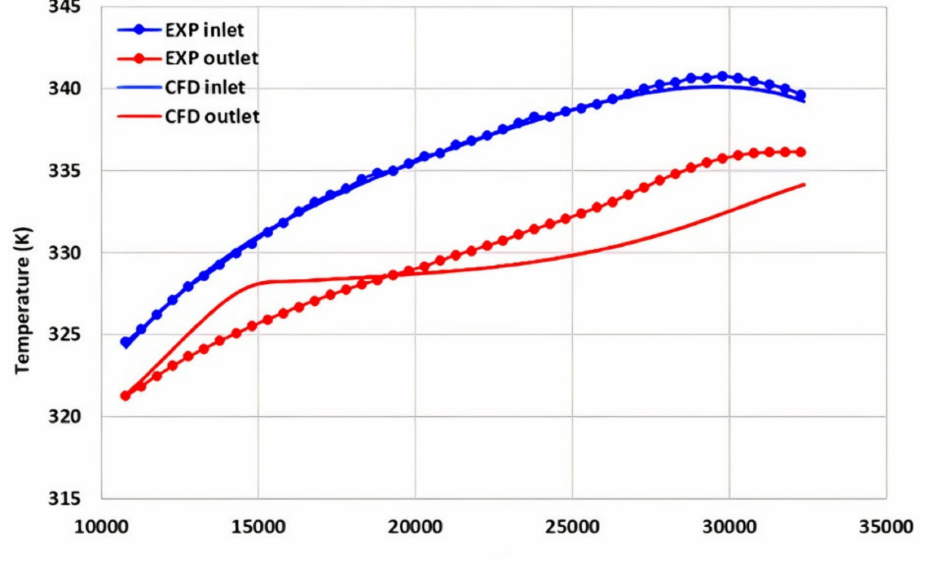
Figure 6. Water temperature comparison of CFD and experimental